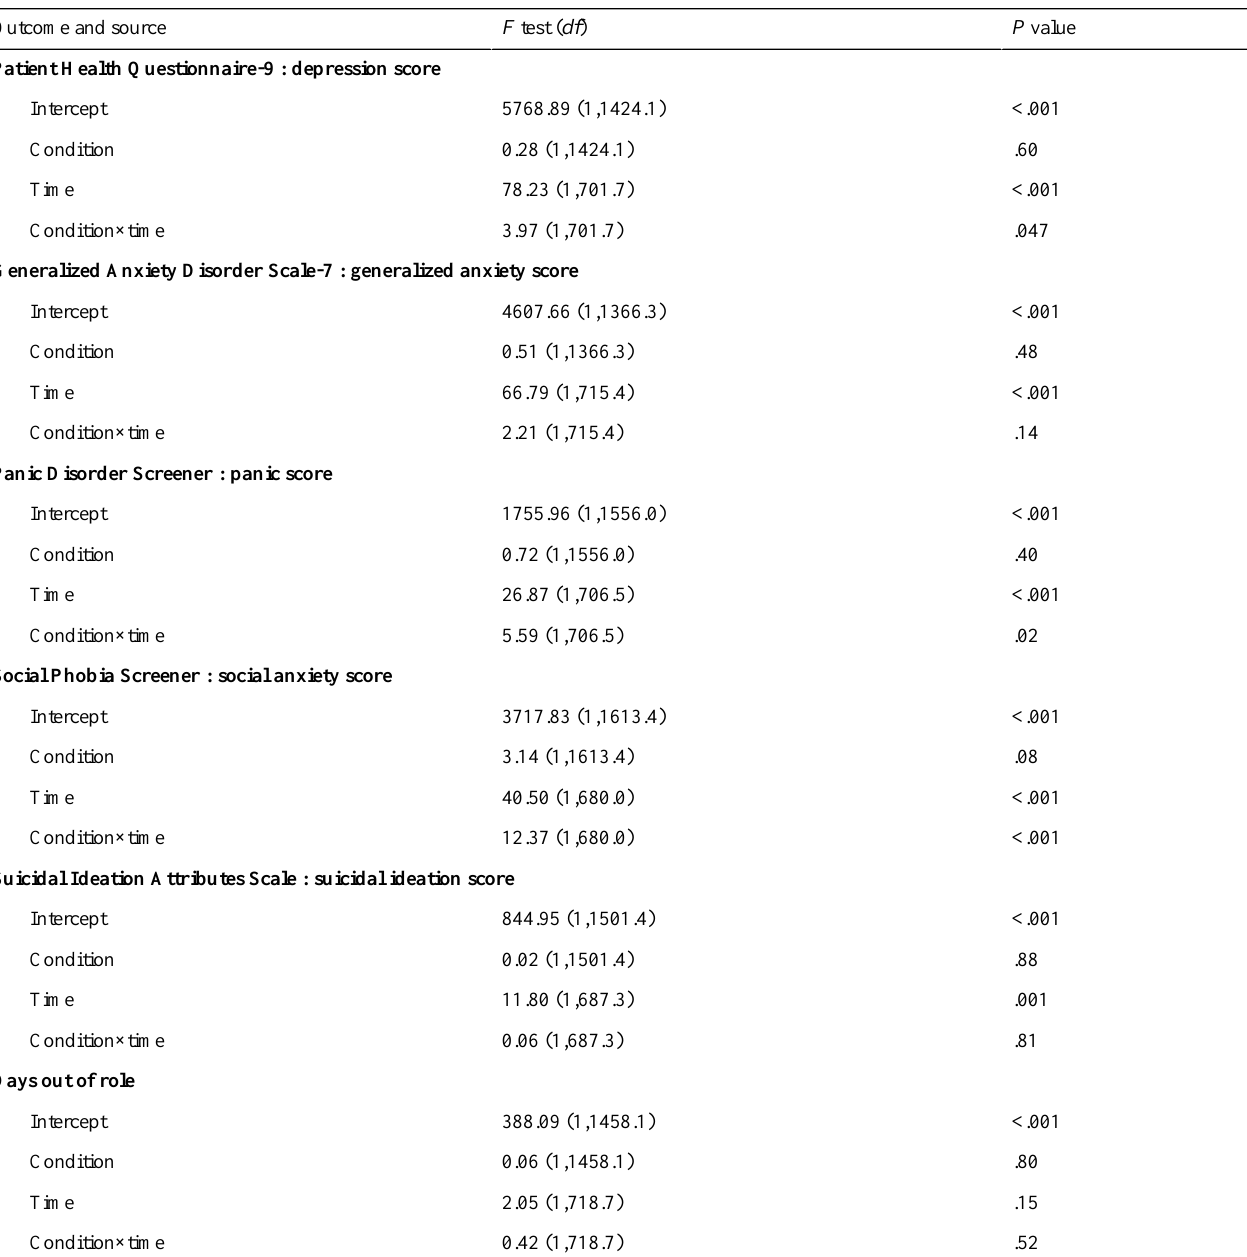
P value F test ( df )Outcome and source